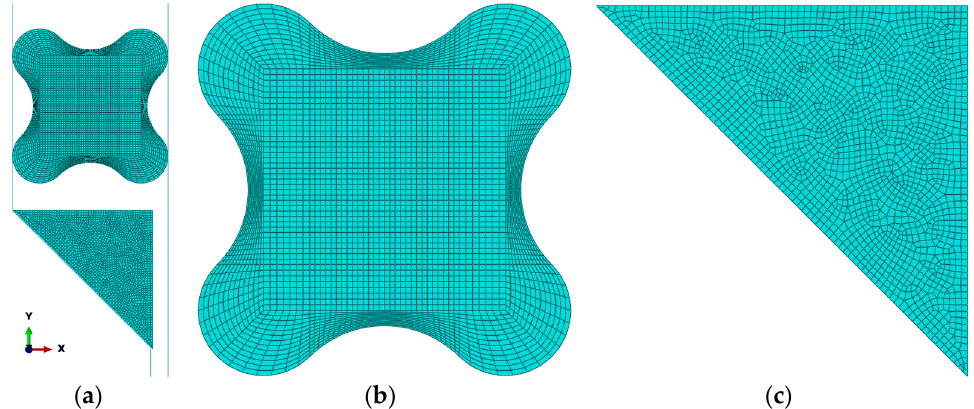
Figure 2. The FEA model of the combined seal. ( a ) General view; ( b ) Partial view of X-ring; ( c ) Partial of wedge-ring.